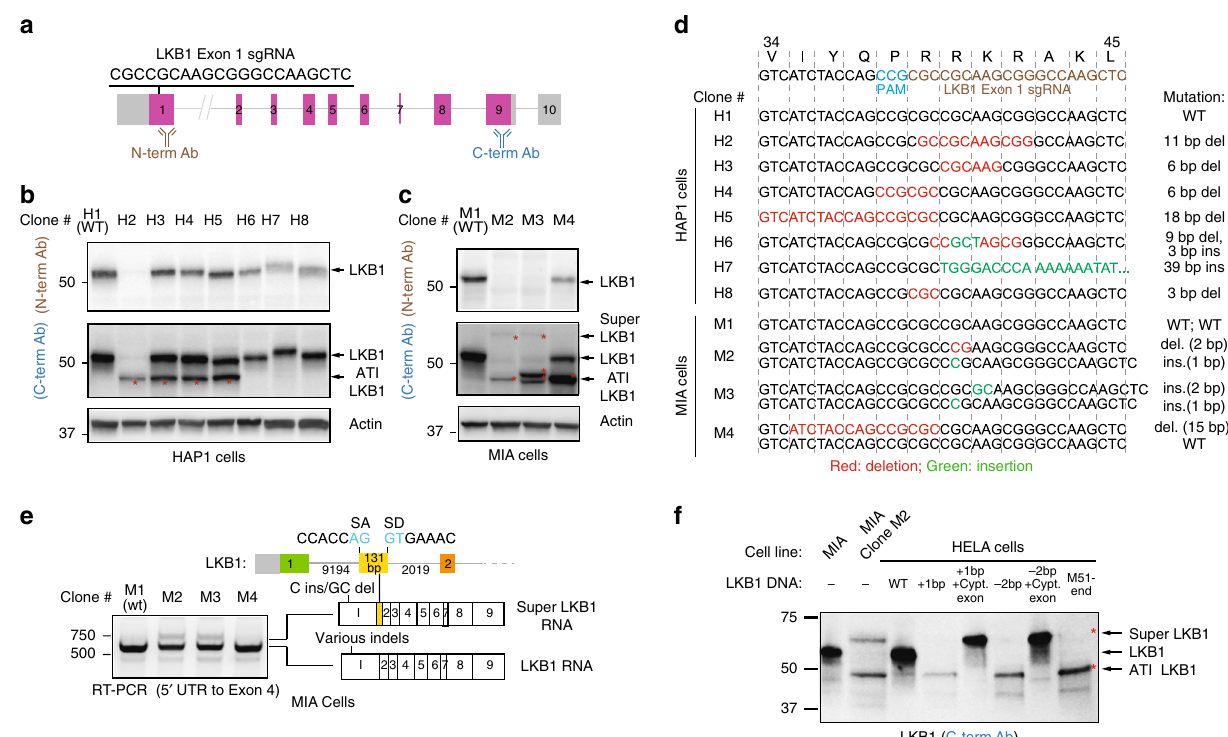
Fig. 3 ATI and pseudo-mRNAs contribute to foreign protein production in CRISPR-edited cell line. a Genomic structure of the LKB1 gene and the exonic sequence targeted by the LKB1 exon 1 sgRNA. b Emergence of a small LKB1 protein (ATI LKB1) as a consequence of CRISPR-Cas9 gene editing. Lysates generated from CRISPR-edited HAP1 clones were subjected to western blot analysis using two distinct LBK1 antibodies recognizing either N- and C- terminus localized epitopes. c Western blot analysis of CRISPR-Cas9-edited MIA clones reveals the appearance of a large LKB1 protein (Super LKB1) in addition to the ATI LKB1 protein. d Genomic sequences of CRISPR-Cas9-edited HAP1 and MIA clones reveal on-target insertion/deletion mutations in the LKB1 gene. Predicted gene alteration for each clone is indicated. e CRISPR-Cas9-introduced INDELs are associated with the expression of an LKB1 pseudo- mRNA transcript. RT-PCR analysis was performed using primers mapping to 5 ′ UTR and exon 4 in LKB1 to generate amplicons from the cDNA of CRISPR- Cas9-edited clones. MIA clones M2 and M3, which express Super LKB1 protein, harbor an mRNA species that includes an additional exon. The 131 bp additional exon contains canonical splice acceptor and donor sequences. f A cDNA expression strategy for understanding allele-speci fi c CRISPR-introduced INDELs on protein expression provides evidence for ATI. LKB1 and Super LKB1 cDNA expression constructs harboring genomic alterations found in LKB1 of MIA Clone M2 were introduced into HELA cells that lack endogenous LKB1 expression. The 1 bp insertion or 2 bp deletion in the Super LKB1 cDNA result in proteins that co-migrate with the Super LKB1 protein observed in MIA Clone M2. On the other hand, the same mutations in LKB1 cDNA give rise to proteins that co-migrate with the ATI LKB1 protein found in Clone M2, and with the protein that initiates at Met51. Source data are provided as a Source Data fi